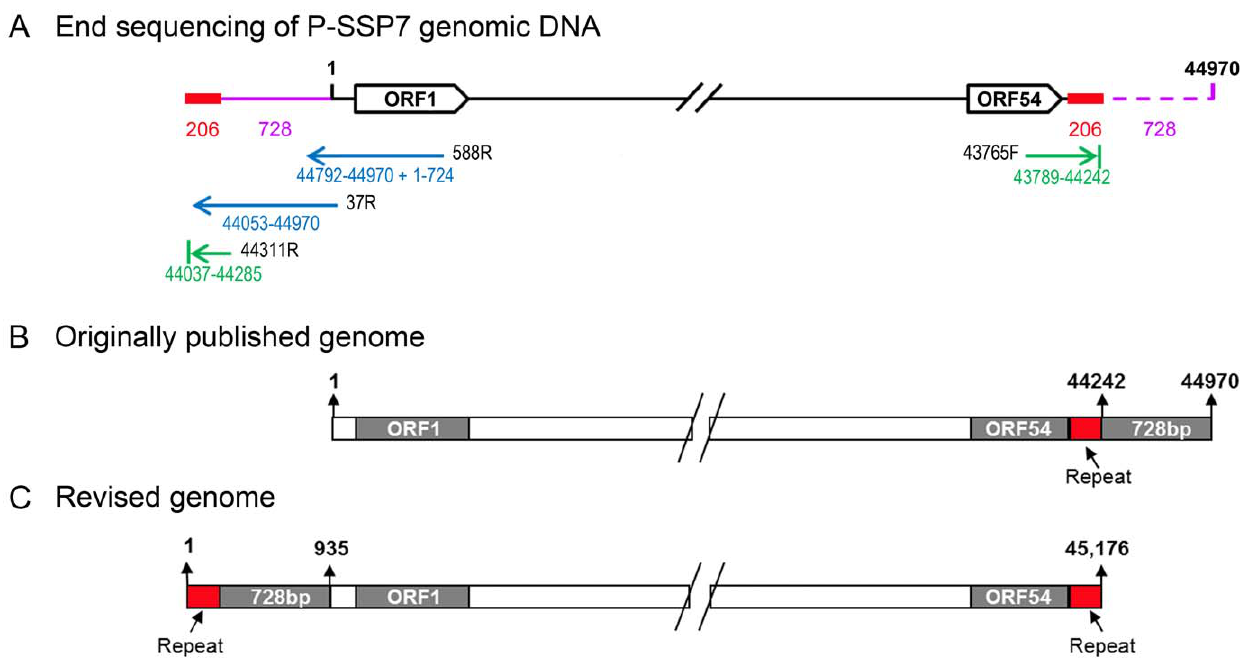
Figure 1. Schematic illustration of the arrangement of the P-SSP7 genome. (A) Sequencing of the ends of the P-SSP7 genome extracted directly from phage particles. Arrows, and numbers under the arrows, indicate the sequences acquired: Blue from the entire genome and green from end fragments produced by digestion of the genome with the BamHI and PmeI restriction enzymes. The positions of the primers used for sequencing are shown in black type at the beginning of the arrows. Genome numbering for the primers and sequences is that for the originally published sequence [5]. The purple line denotes the 728 bp region found to be upstream of ORF1 in this study, but positioned downstream of ORF54 in the originally published sequence. The repeat regions are shown in red at both ends of the genome. (B) Diagram showing the arrangement of the P-SSP7 genome as originally published (GenBank accession numbers: AY939843.1, [5] and GU071093 [16]. (C) Diagram of the revised genome arrangement based on the results from this study (updated GeneBank submission, accession number: AY939843.2).